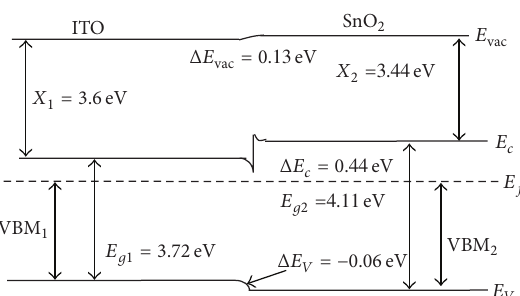
F 12: Energy band diagram of the ITO/SnO